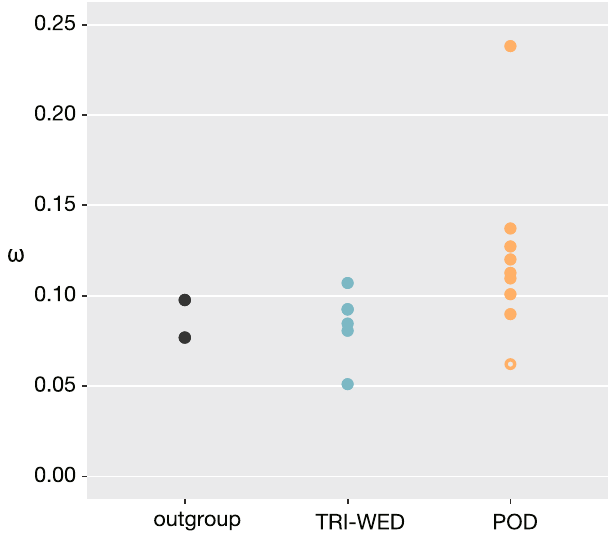
Fig. 7 Plot of ω in the branches of outgroup, basal subfamilies, and Podostemoideae. The orange open circle indicates the Podostemoideae stem branch. POD Podostemoideae, TRI Tristichoideae, WED Weddellinoideae.